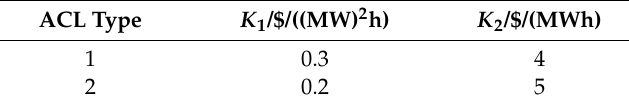
Table 2. Parameters of the compensation cost.